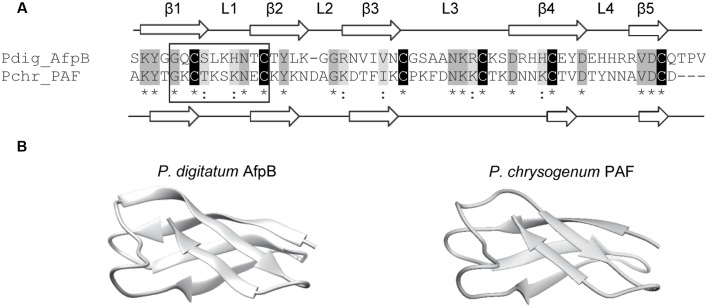
Molecular modeling of the P. digitatum class B antifungal protein AfpB. (A) Amino acid sequence alignment of AfpB and P. chrysogenum antifungal protein PAF. Cysteines are shadowed in black, other conserved amino acids in dark gray, and similar amino acids in light gray. Asterisks below sequences indicate conserved amino acids and colons similar amino acids. PAF and predicted AfpB β-sheets are labeled as β1 to β5 white arrows; and loops are labeled as L1 to L4. The γ-core motif is boxed. (B) Comparison of the tertiary structure of PAF (right) with the 3D molecular model obtained for AfpB (left).